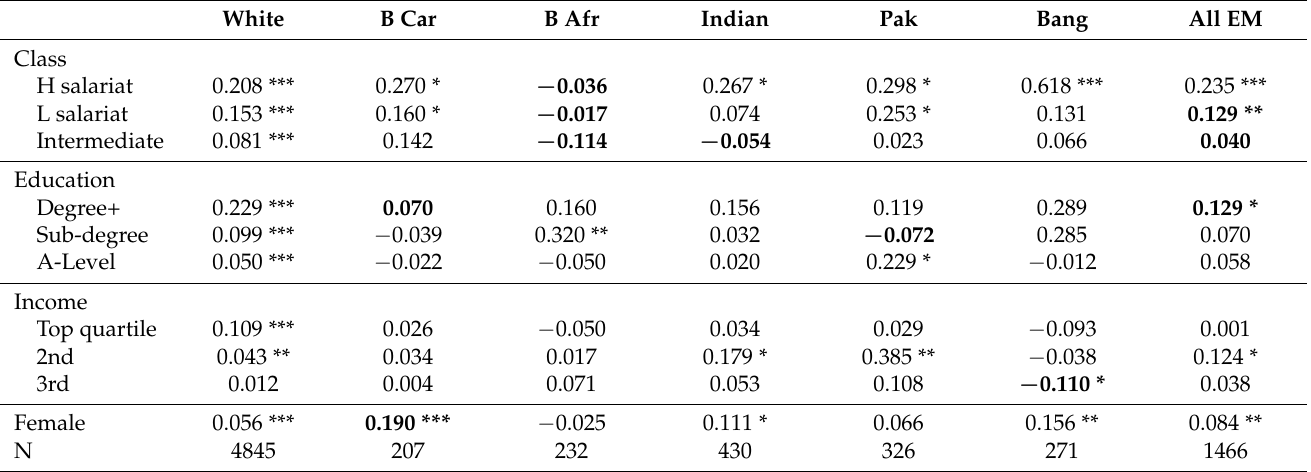
Table 5. Average marginal effects from ordinal logit regression on educational qualifications at age 25 on parental resources and personal attributes with predicted probabilities on degree